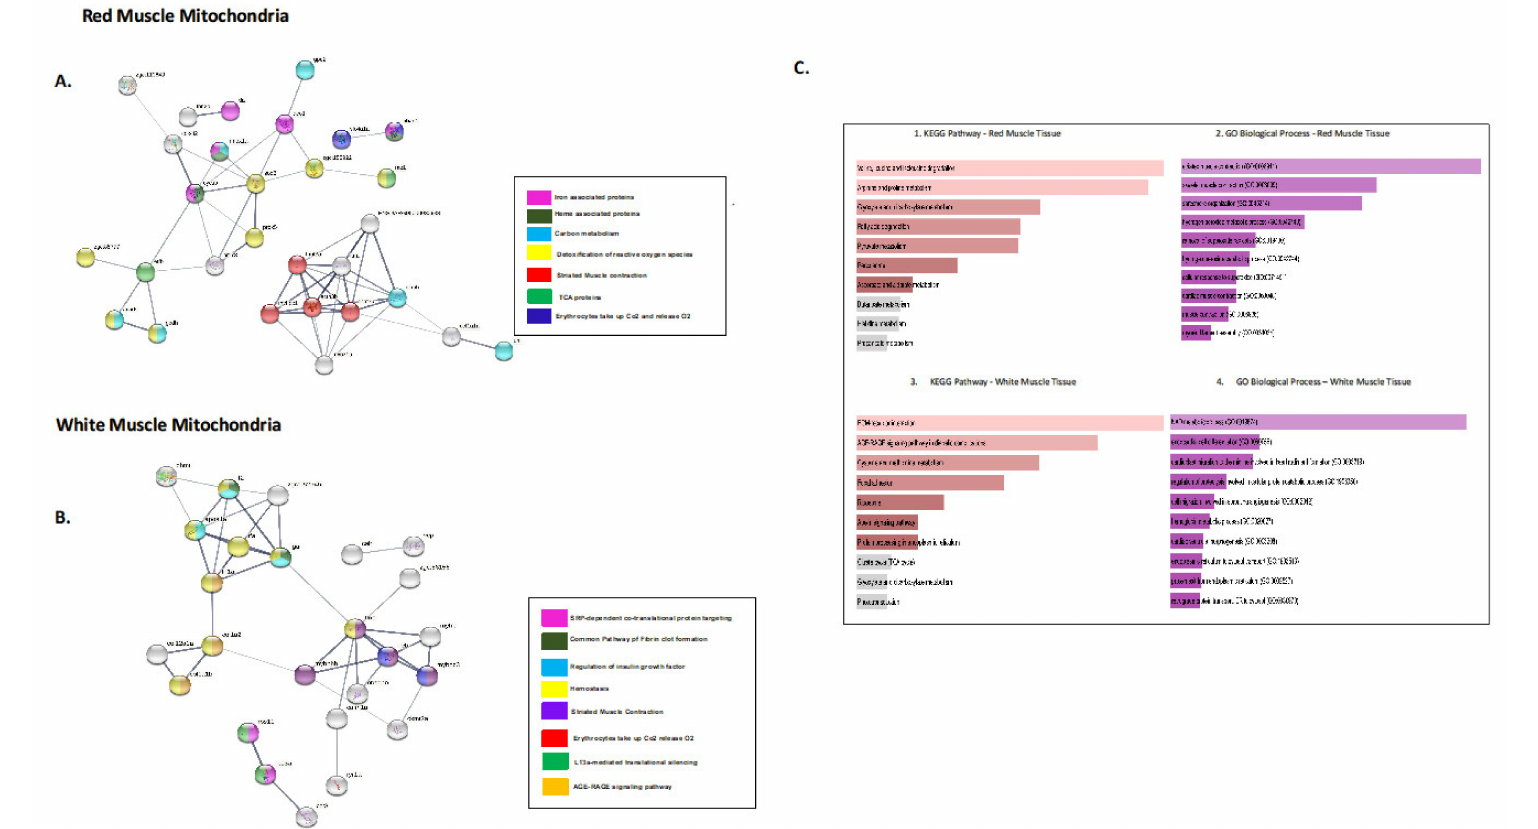
Figure 5. Network analysis of proteins lower expressed in icefish in comparison to closely related red-blooded species. ( A ) RMM DEPs, number of nodes 48 with 53 edges, the average node degree is 2.52 and ( B ) WMM, number of nodes 32 with 45 edges, the average node degree is 2.5. Network analysed using STRINGdb. The network highlights proteins involved in different pathways curated by string from Reactome database. The nodes are coloured according to the pathways determined with Reactome Pathway Database. The edge shows type of interactions, experimentally determined interactions derived from databases, predicted interactions such as gene neighbourhood, gene co-occurrence, and gene fusions, respectively, co-expression interactions, text-mining interactions and homology, thicker the edge higher the confidence obtained the mentioned sources. ( C ) Using FishEnrichr analyser KEGG Pathway and GO terms for biological process showed proteins involved in different